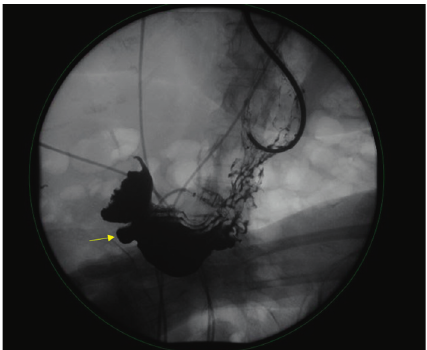
Figure 3: Upper gastrointestinal contrast radiographic study. The patient was discovered to have a distal antral diverticulum of the under surface of the gastric body